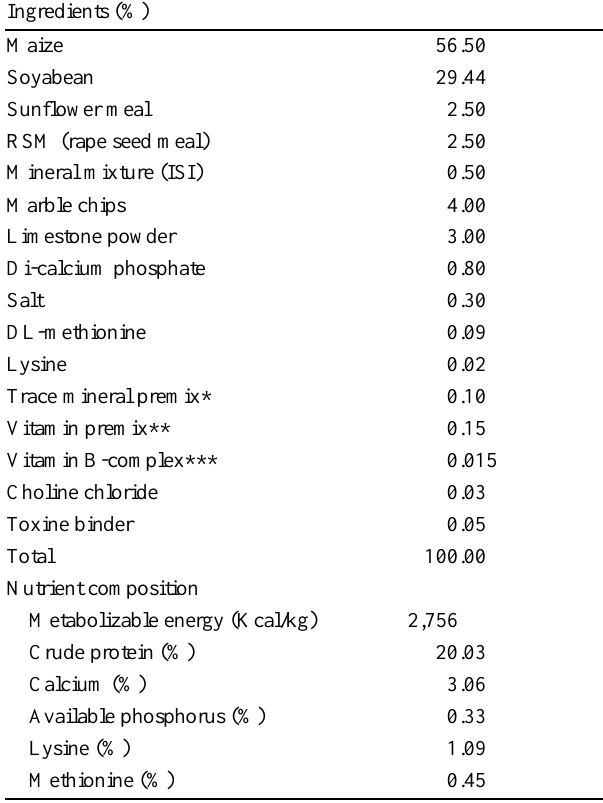
Table 1. Formula and chemical composition of control diet used in the current